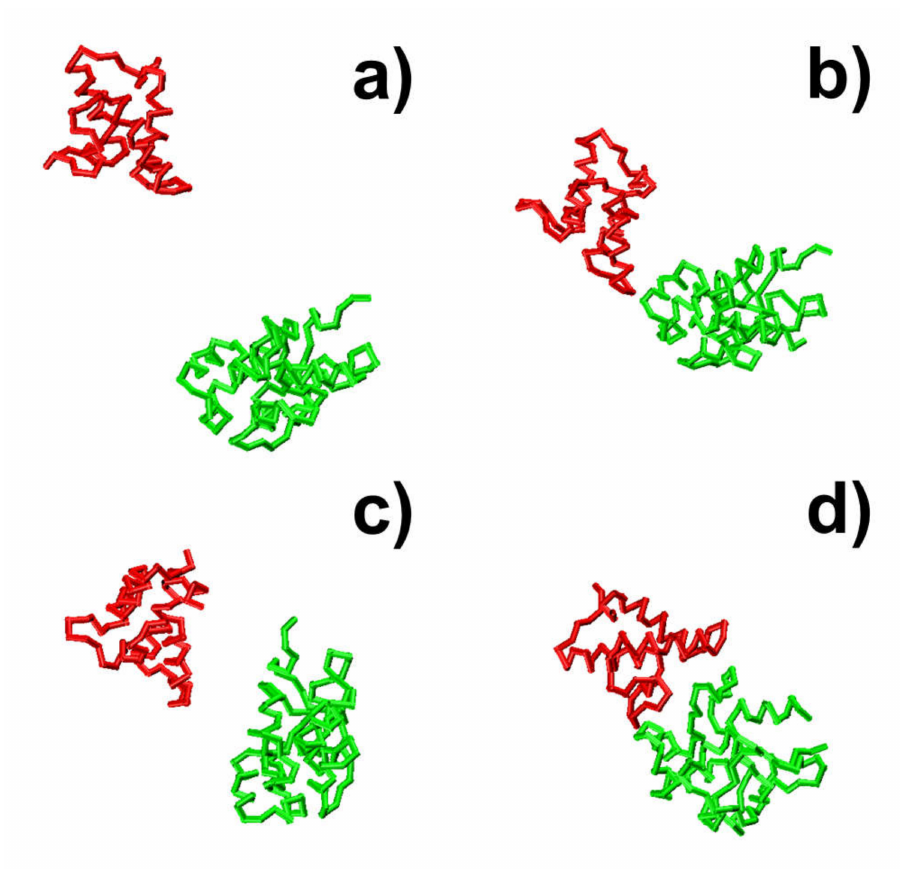
Figure 4. The snapshots of four representative kinetic steps along the association pathways are illustrated for protein complex 2VLN. Two binding partners in the complex are shown in red and green, respectively. The initial configuration is shown in ( a ). In ( b ), a tentative binding interface is formed between two binding partners, corresponding to a local energy minimal state denoted by the number “2” in Figure 3. This tentative complex was then dissociated, and two binding partners were reorganized into a di ff erent orientation, as illustrated in ( c ) and the number “3” in Figure 3. At the end of the simulation, the final encounter complex forms, as shown in ( d